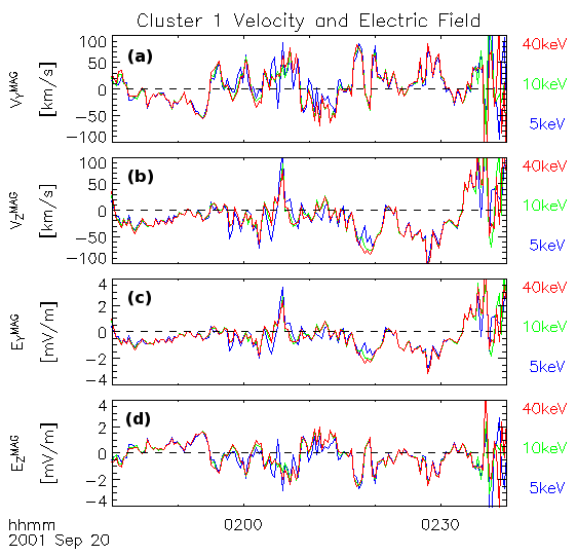
Fig. 9. The Y MAG and Z MAG components of V (a, b) and E (c, d) , obtained by integration of the 3-D CODIF H + distributions from SC1 over three energy ranges, from 40eV up to 5keV (blue), 10keV (green), and 40keV (red). As for SC1, the results for SC3 and SC4 (not shown) do not exhibit a significant dependence on the upper limit of the energy range.